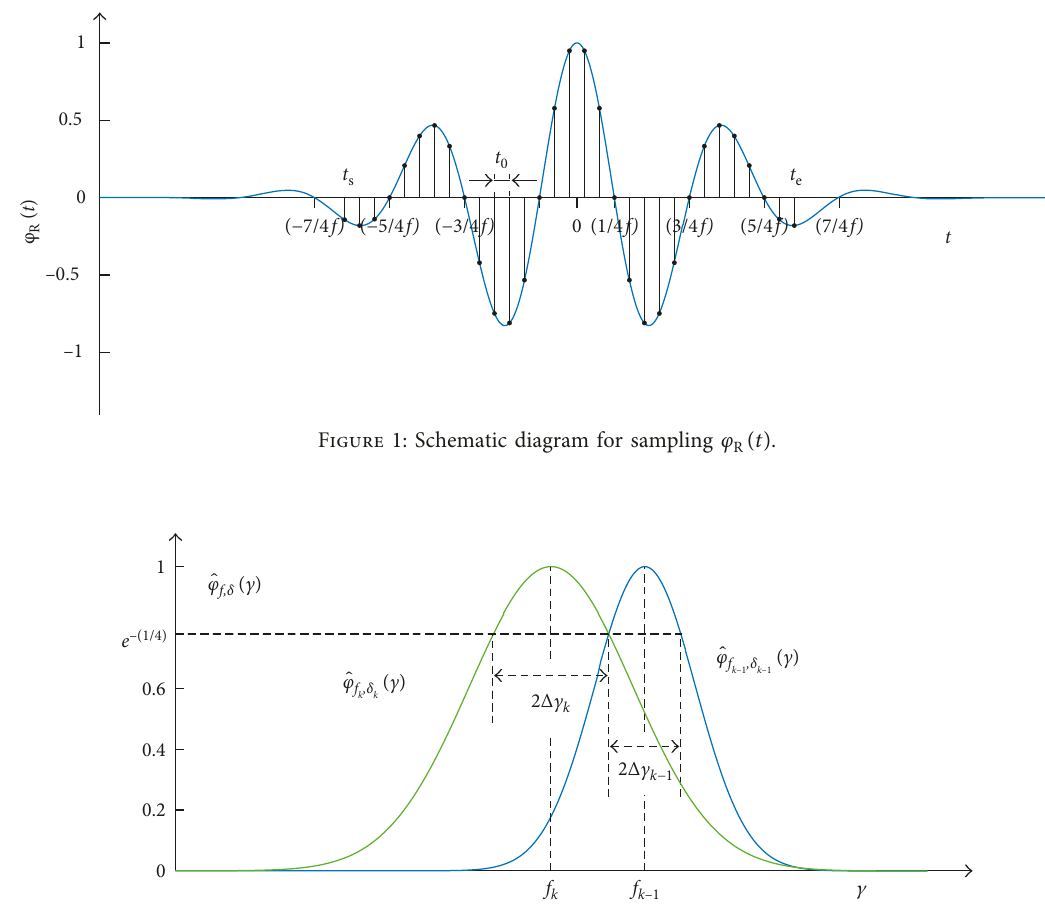
Figure 2: The first situation of two adjacent Morlet